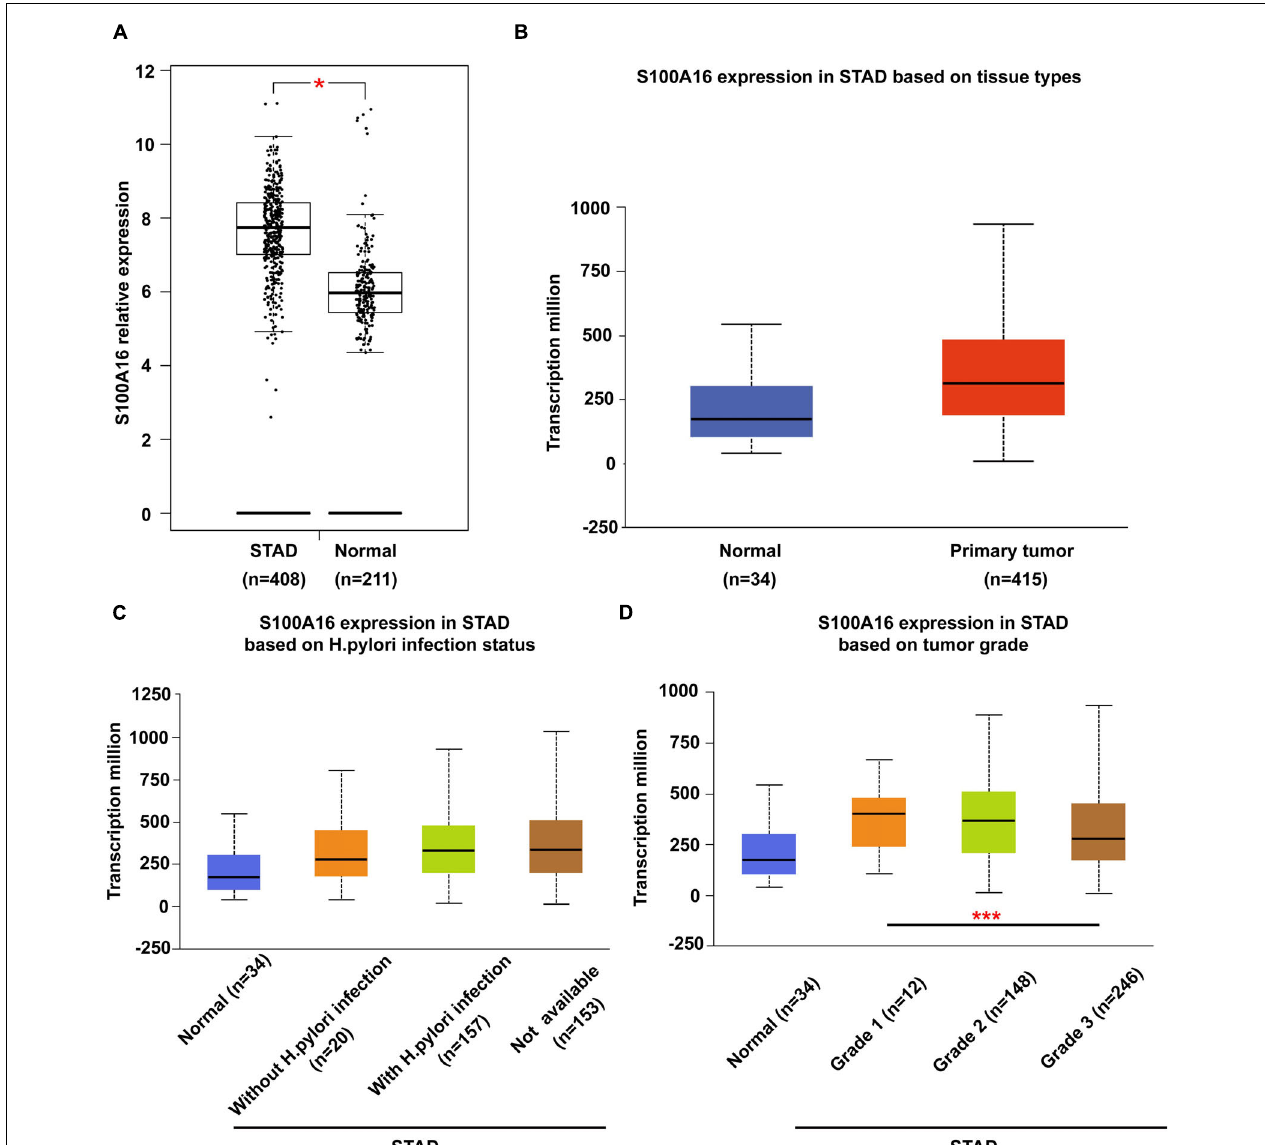
FIGURE 1 | Bioinformatic analysis of S100A16 expression in GC. (A,B) S100A16 expression in human GC tissues according to GEPIA and UALCAN database. (C) Boxplot showing expression of S100A16 associated with H. pylori infection status. (D) Boxplot showing relative expression of S100A16 in normal individuals or GC patients with grade 1, 2, or 3 tumors. For panels (A–D) , * P < 0.05 and *** P < 0.001 vs. normal group or Grade 1